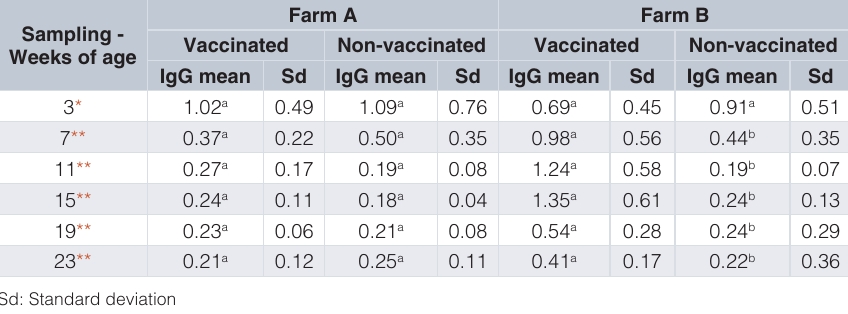
Table 1. Mean IgG levels distributed by week of age (3, 7, 11, 15, 19, and 23), farm (A and B), and treatment (vaccinated and non-vaccinated). Mean IgG levels are compared within farm (vaccinated vs. non-vaccinated) and between farms (VAC-A vs. VAC-B). Different letters within farm indicate a significant difference (p<0.05) in the mean IgG level between vaccinated and non-vaccinated pigs. The significance level of difference in the IgG level between vaccinated pigs in farm A (VAC-A) and Farm B (VAC-B) by week are indicated with * (p<0.05) and ** (p<0.01). Pigs were vaccinated at week 3 and on farm B they received a booster at week 5.